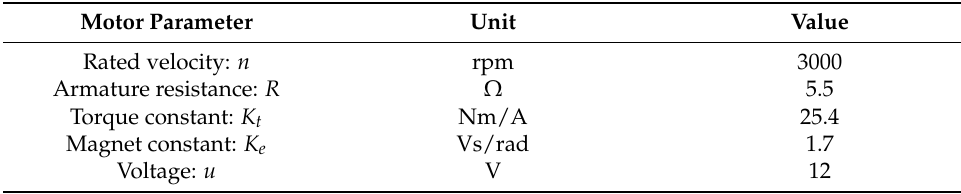
Table 4. Parameters of the vibration motor.